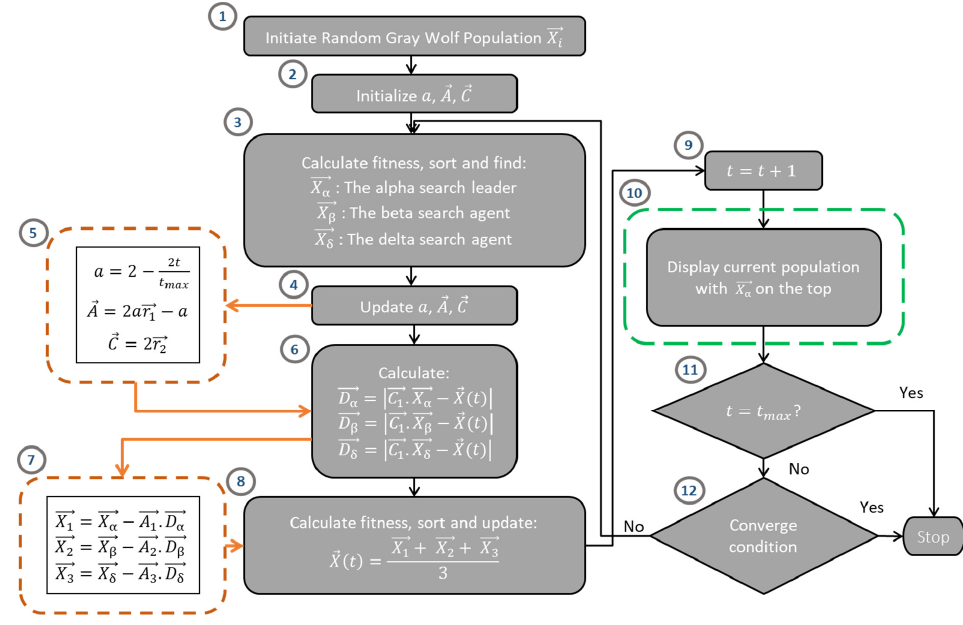
Figure 6. Flowchart of GWO algorithm.